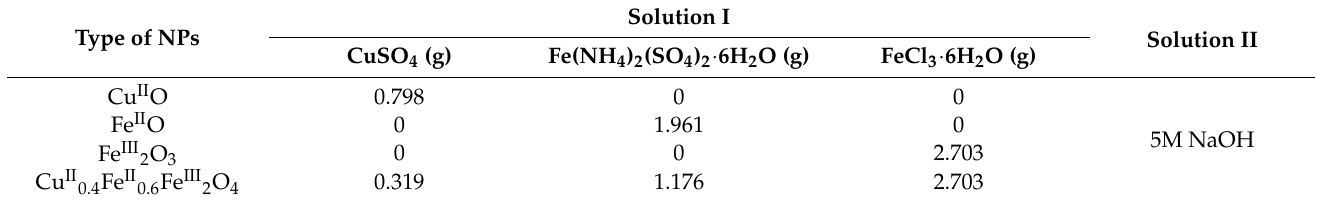
Table 1. Metal salts used for the synthesis of oxide nanoparticles (NPs).